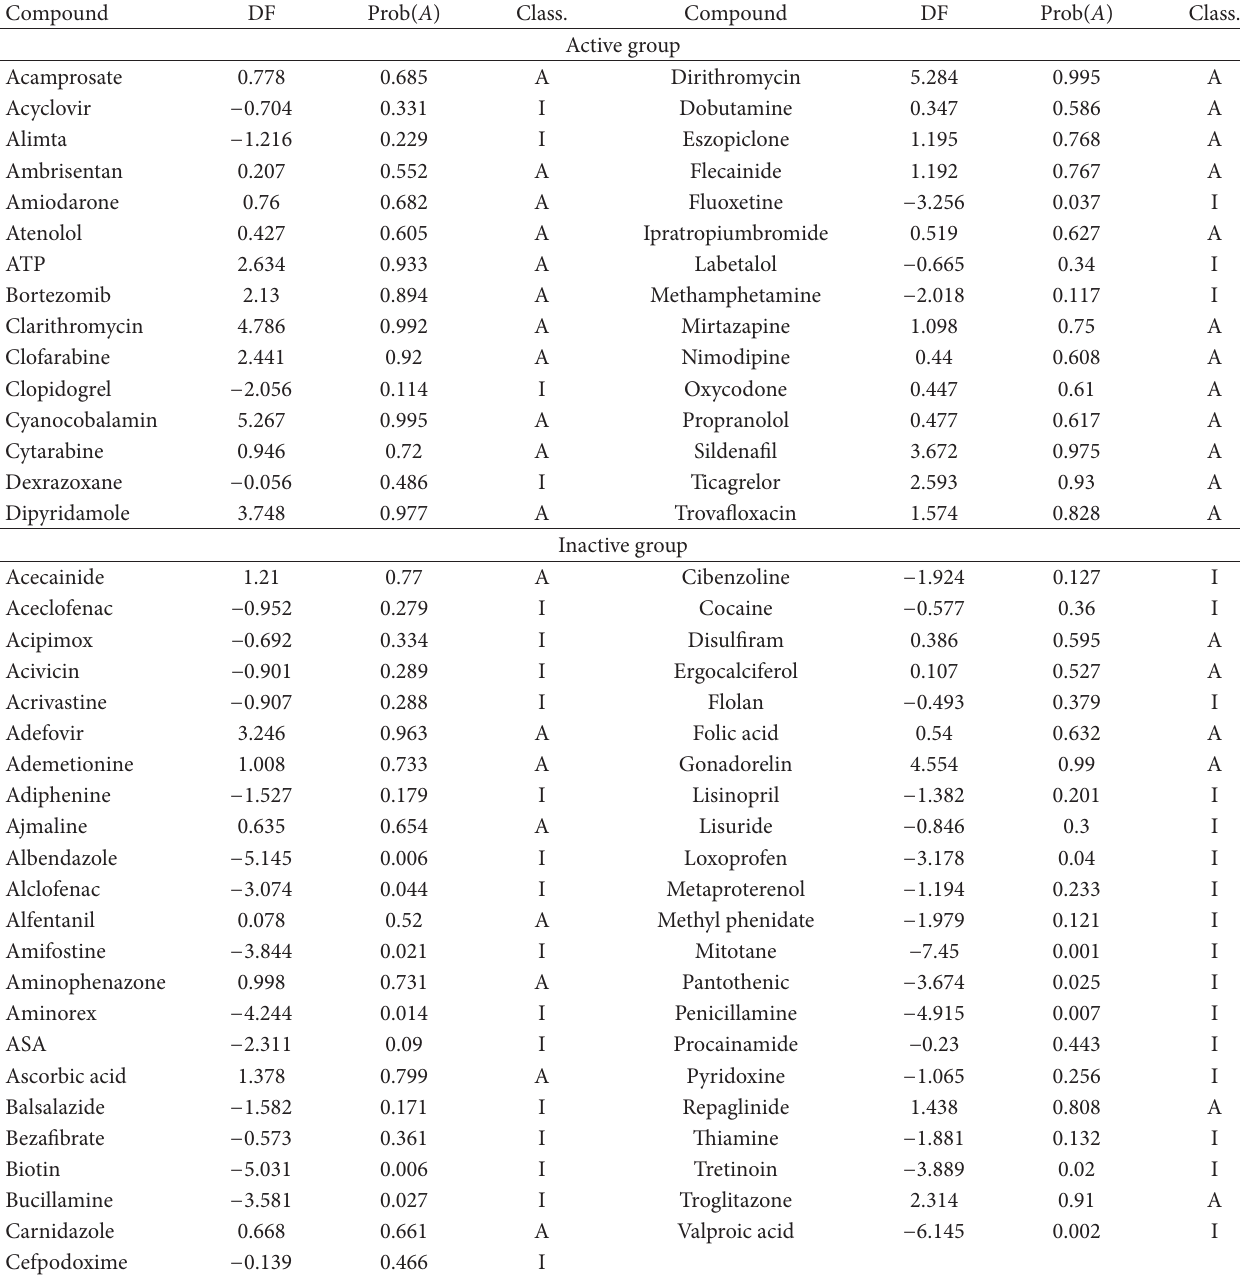
T 3: Results of prediction of dyspneagenicity through the discriminant function DF for the test